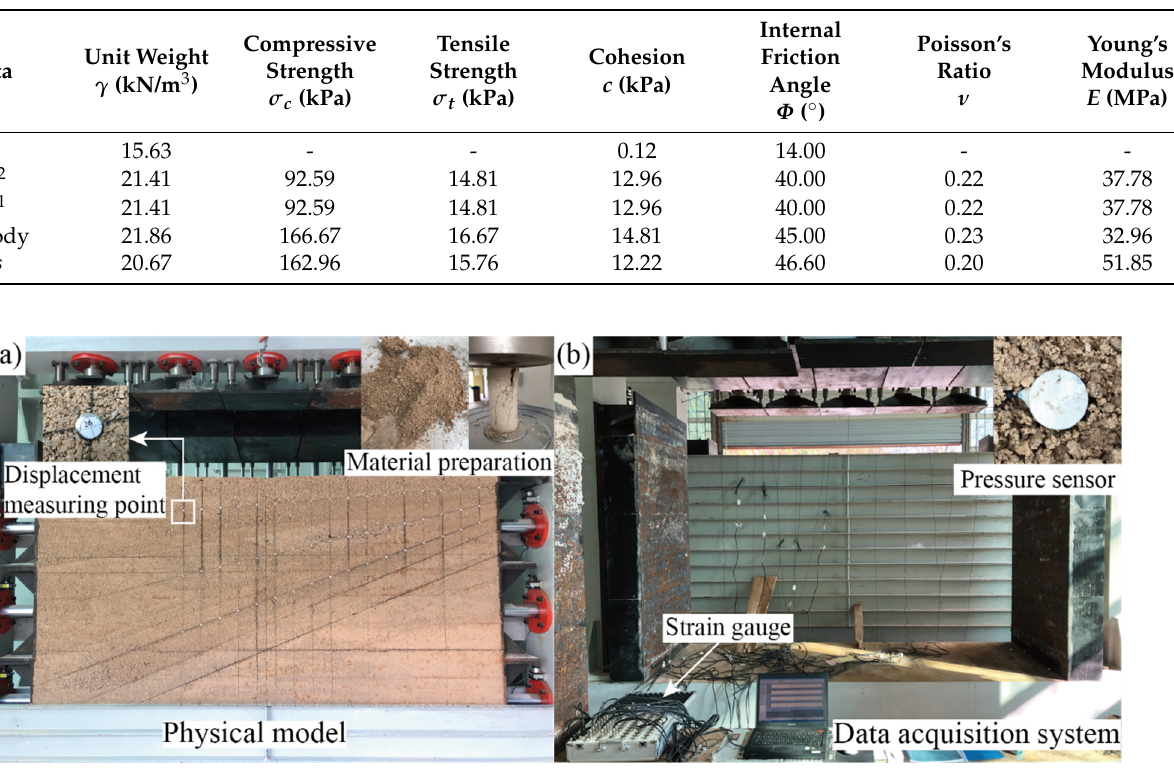
Table 1. The mechanical parameters of similar materials.